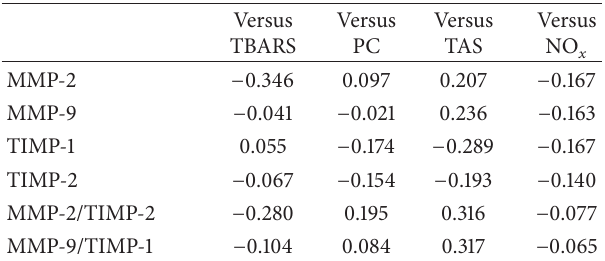
Table 5: Correlations between oxidative parameters and gelatinases in nondiabetic MS